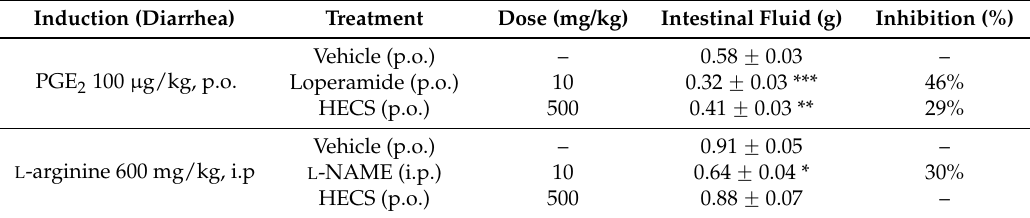
Table 5. Effect of the hydroalcoholic extract of Cissus sicyoides (HECS) on PGE 2 and L -arginine-induced intestinal fluid accumulation. Induction (Diarrhea) Treatment Dose (mg/kg) Intestinal Fluid (g) Inhibition (%) Vehicle (p.o.) – 0.58 ˘ 0.03 – PGE 2 100 µ g/kg, p.o. Loperamide (p.o.) 10 0.32 ˘ 0.03 *** 46% HECS (p.o.) 500 0.41 ˘ 0.03 ** 29% L -arginine 600 mg/kg,